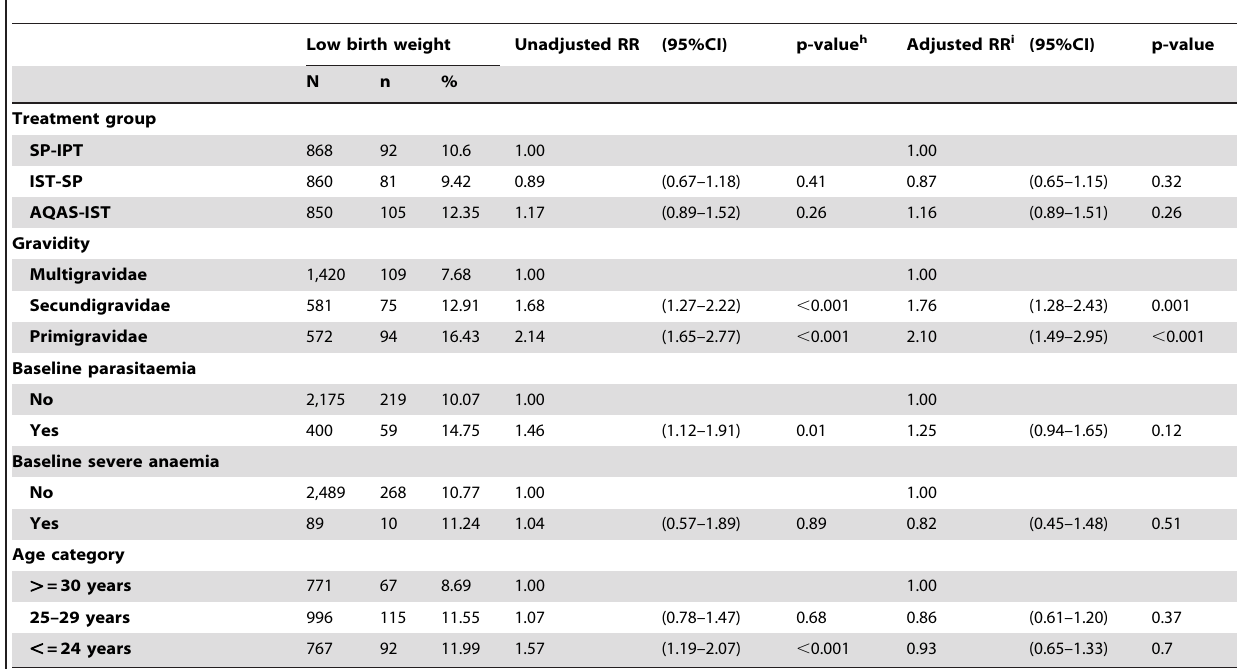
Figure 3. The effect of IST with AS + AS or SP compared with SP-IPTp on the risk of third trimester severe anaemia (panel A) or low birth weight (panel B) in women who received these interventions. The error bars shown indicate 2-sided 95% confidence intervals (CIs). The areas bound by 2 5 to 5 (panel 3A) and 2 4 to 4 (panel 3B) indicate zone of non-inferiority. In both panels the CIs lie to the left of the upper boundaries of the CIs and include zero indicating IST is non-inferior to SP-IPTp. Table 4. Factors associated with low birth weight of babies delivered by study women.